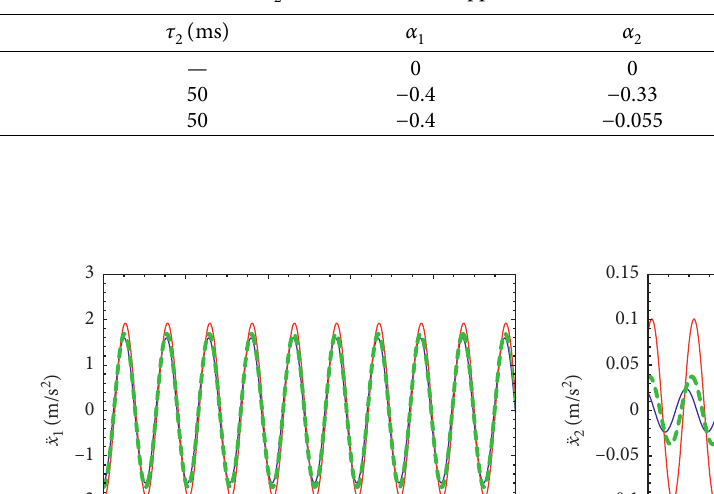
Table 2: Effect of α